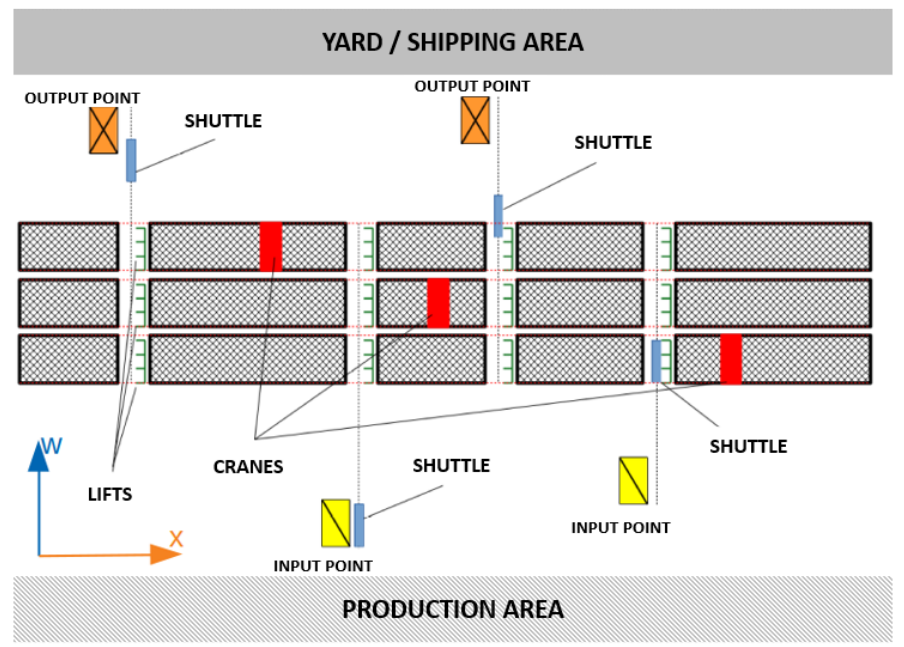
Figure 5. Schematic representation of SLC-AS/RS elements.